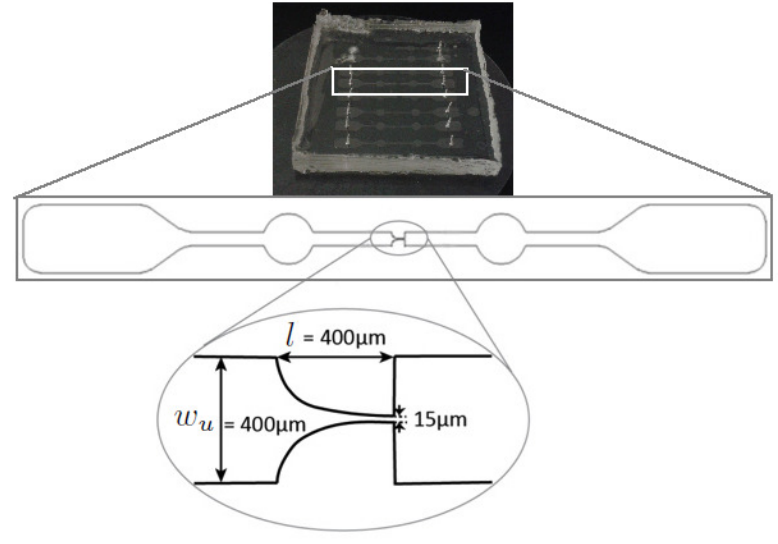
Figure 1. A schematic top-view of the microchannel. The width ( w u ) and contraction length ( l ) are 400 µm. The width of the exit of the contraction region ( w c ) and the depth of the channel ( h ) were 15 µm.